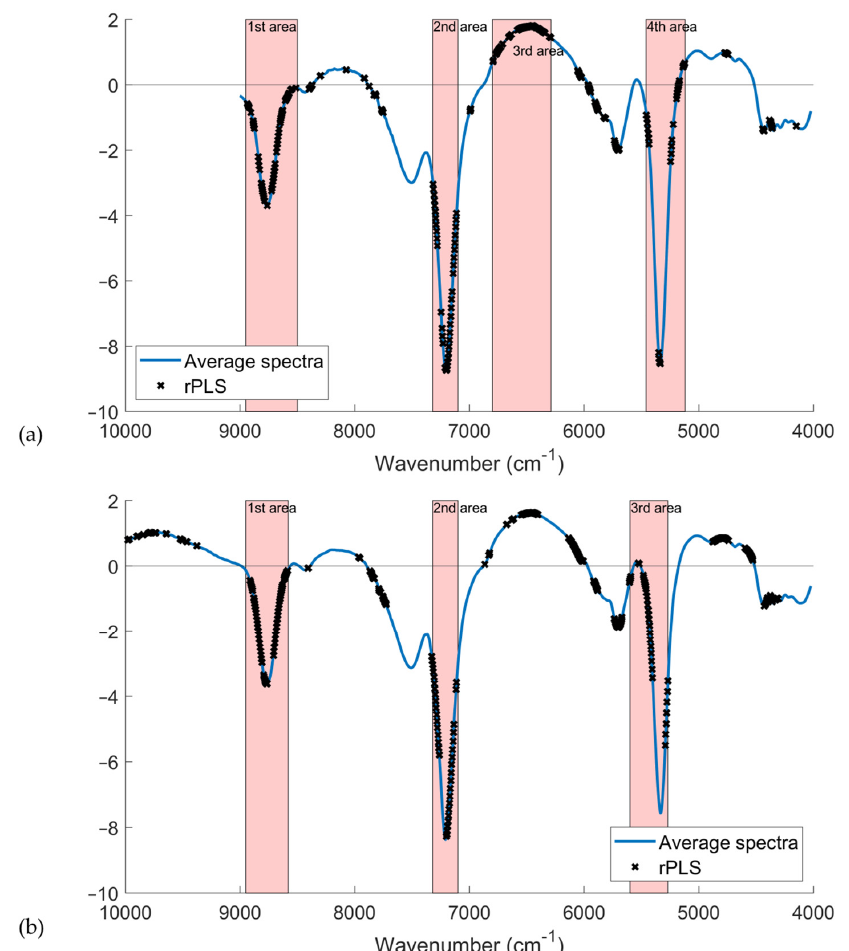
Figure 6. ( a ) Average spectrum of DB-2020 dataset pretreated using first derivative (Savitzky–Golay filter, 13 smoothing points, second polynomial order) on the spectral range from 9000 to 4000 cm − 1 ; ( b ) average spectrum of DB-2021 dataset pretreated using first derivative (Savitzky–Golay filter, 13 smoothing points, second polynomial order) on all the spectral range. The variables selected by rPLS are marked with black crosses. The red areas mark the most important wavenumber range for the prediction of SSC content (°Brix).